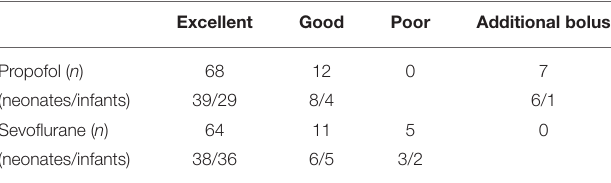
TABLE 3 | Comparison of the quality of intubation between infants induced with propofol and sevoflurane. Excellent Good